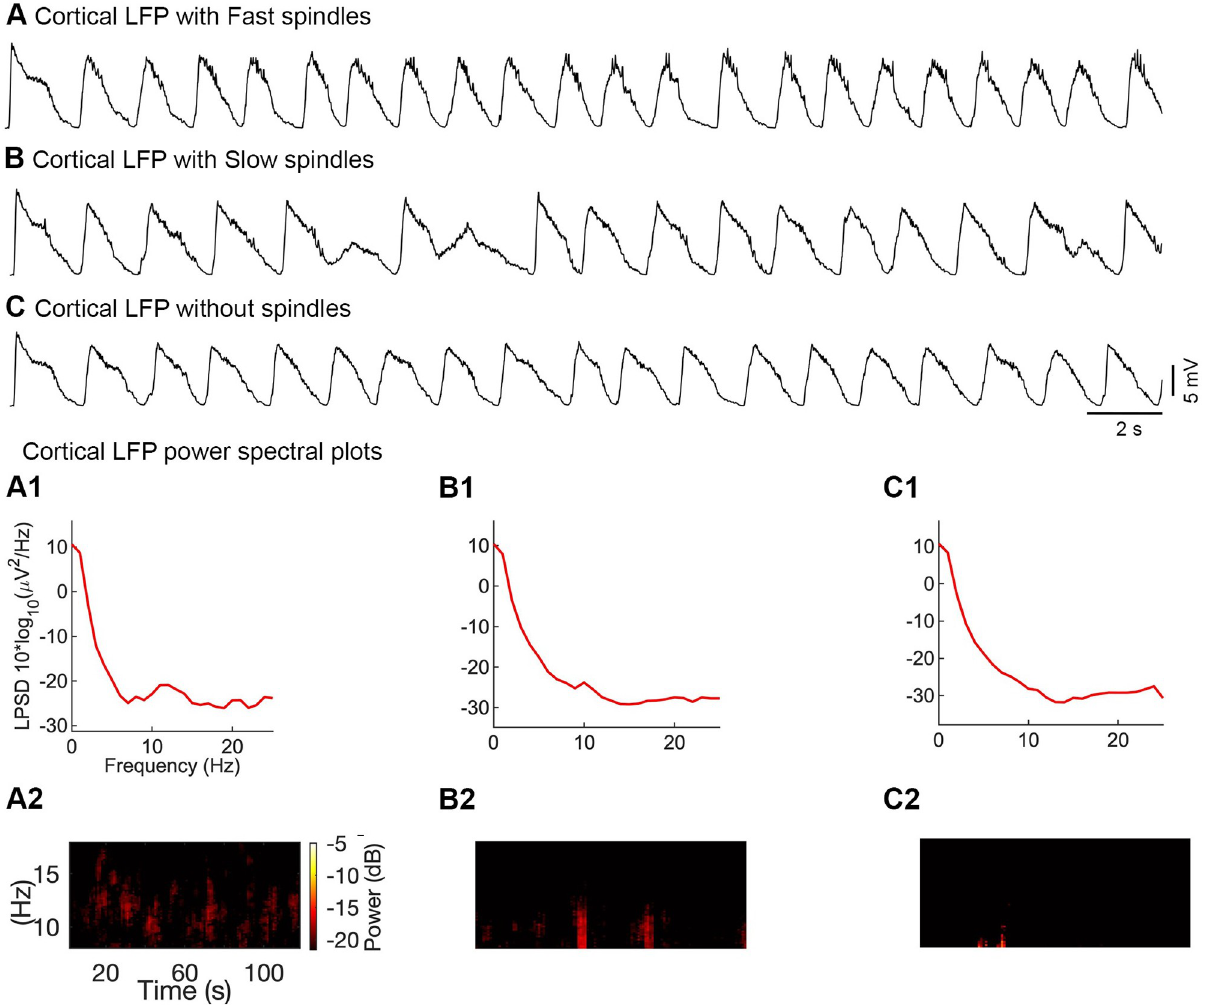
Fig 4. The influence of different thalamic inputs on the cortical LFP. A , The cortical LFP coupled with fast thalamic spindles (slow spindles were blocked). Slow thalamic network layers (layers 5 and 6) were blocked by setting synaptic conductance to zero between PY-TC(S) and PY-RE(S) cells. A1 , Power spectra of the cortical LFP with fast thalamic spindles A2 , The corresponding time-frequency spectrogram of cortical LFP. B , The cortical LFP with slow spindles (fast spindles were blocked). B1 , The corresponding power spectra of LFP. B2 , The corresponding time-fraency spectrogram of LFP. In the spectrum, the number of slow spindles was relatively low compared to fast spindles (See A2 ). C , The cortical LFP without fast and slow thalamic inputs. Fast and slow spindles disappeared in both the power ( C1 ) and time-frequency ( C2 )